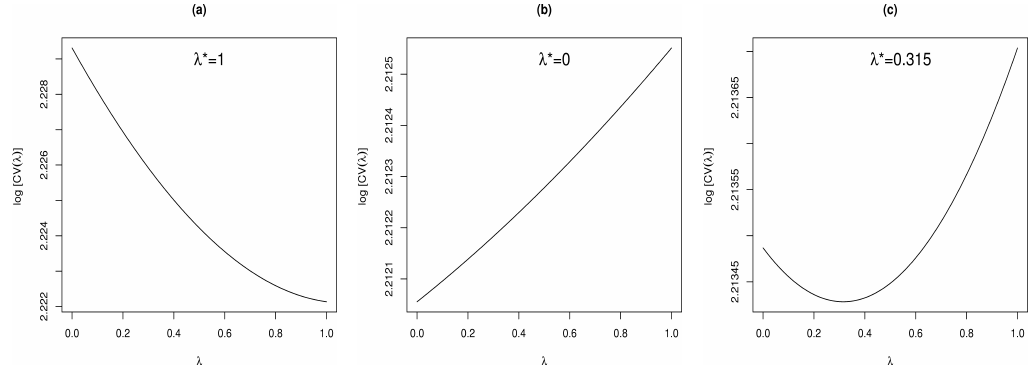
Fig. 1. Relationships between λ and log [ CV ( λ )] in three simulations (a),(b) and (c) and the corresponding selection of λ